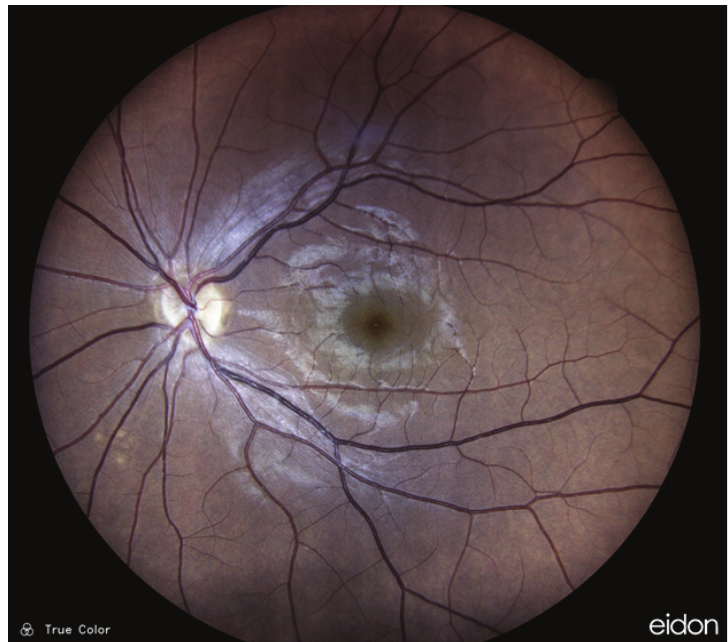
Figure 4. Color fundus photo of the left optic nerve three months after presentation shows mild temporal disc pallor.